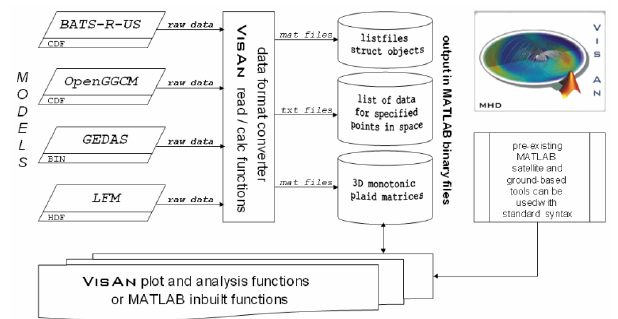
Fig. 1. VisAn MHD data flow diagram.